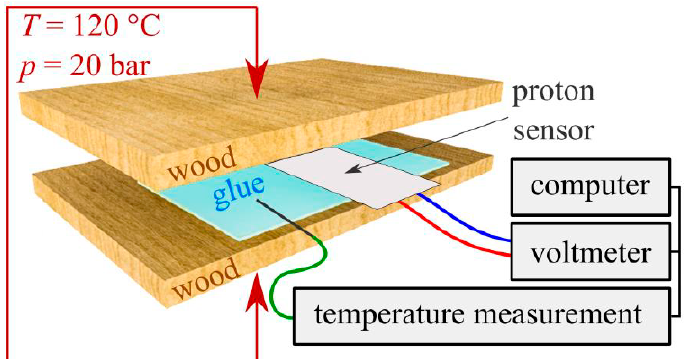
Figure 2. Schematic presentation of the experimental setup for the in-situ measurements of cross- linking.